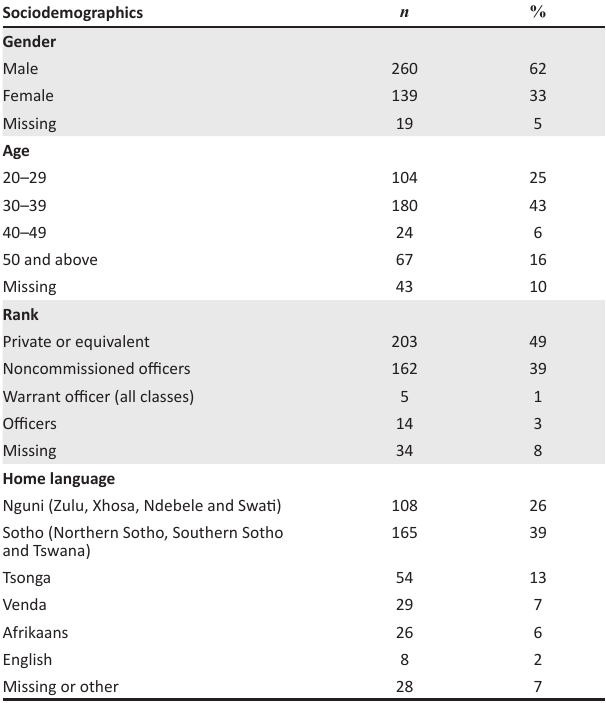
TABLE 1: Sociodemographic characteristics of